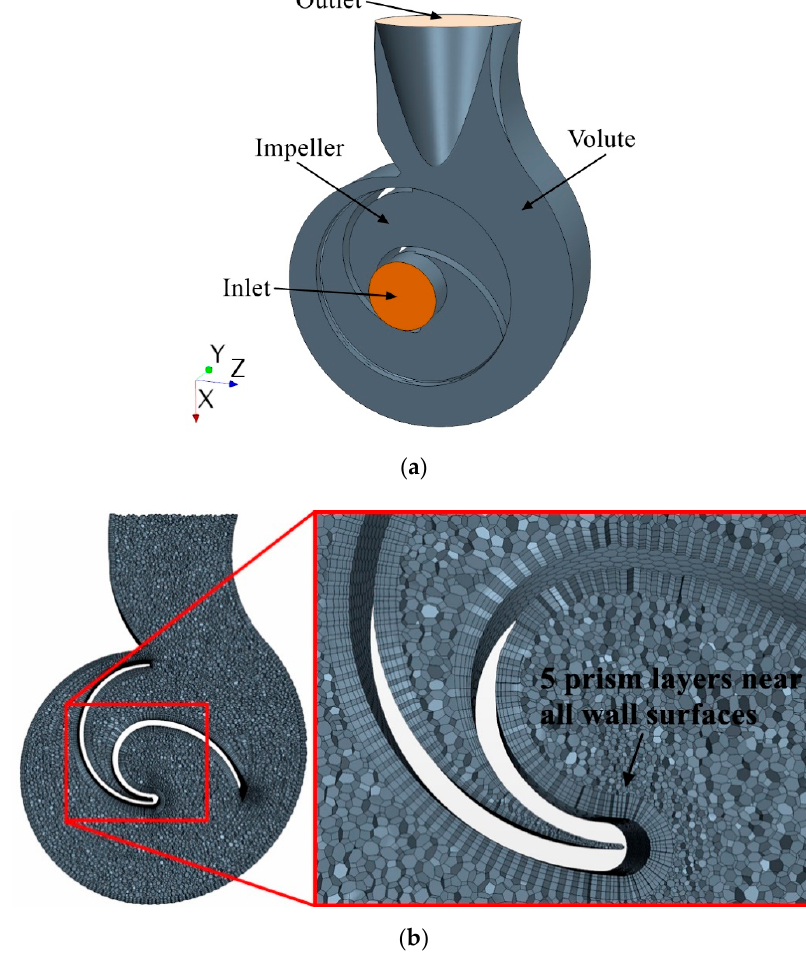
Figure 1. ( a ) Computational domain; ( b ) mesh cells. Table 1. Mesh dependency test.